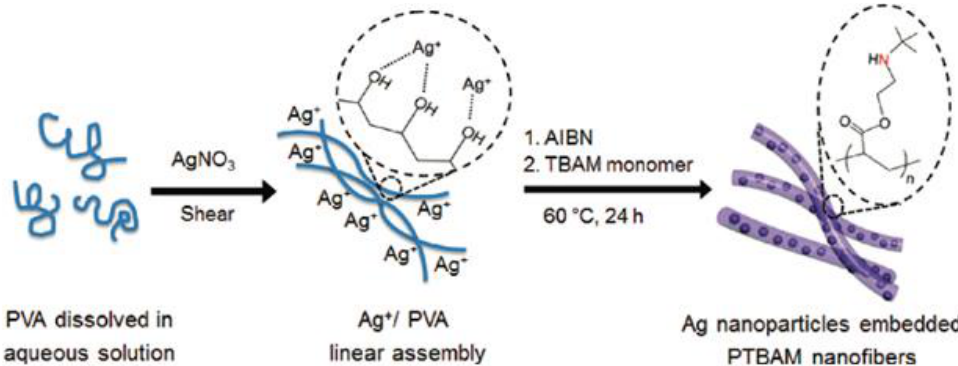
Figure 7. Illustration of the synthetic procedure of AgNPs embedded PTBAM nanofibers. Reproduced with permission from reference [99]. Copyright 2011 ACS.